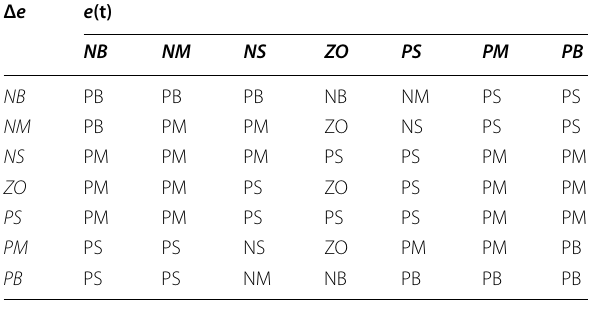
Table 2 Control rules of the fuzzy integral control